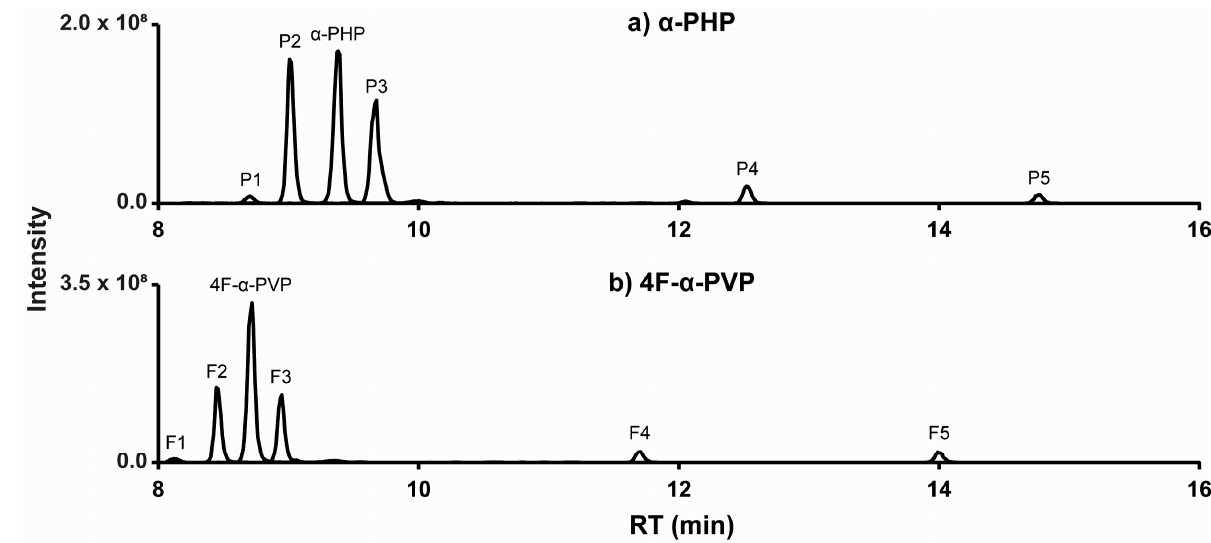
Figure 4. Combined extracted ion chromatogram of α -PHP ( a ), 4F- α -PVP ( b ), and metabolites obtained from 3 h hepatocyte incubation. Mass tolerance, 5 ppm; RT, retention